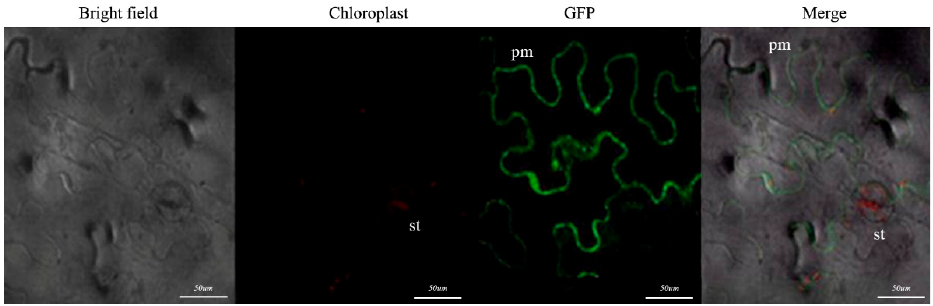
Figure 6. PsARRO − 1 subcellular localization. The scale bar is 50 µm. (pm: plasma membrane; st: stomata).